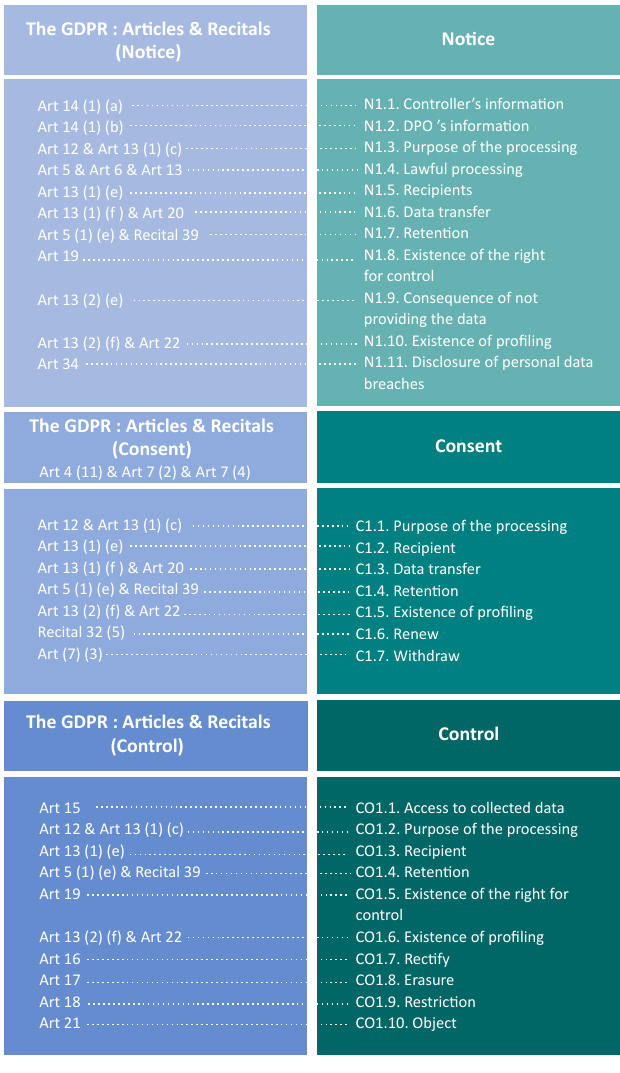
Figure 6. The correspondence between the guidelines and the original GDPR